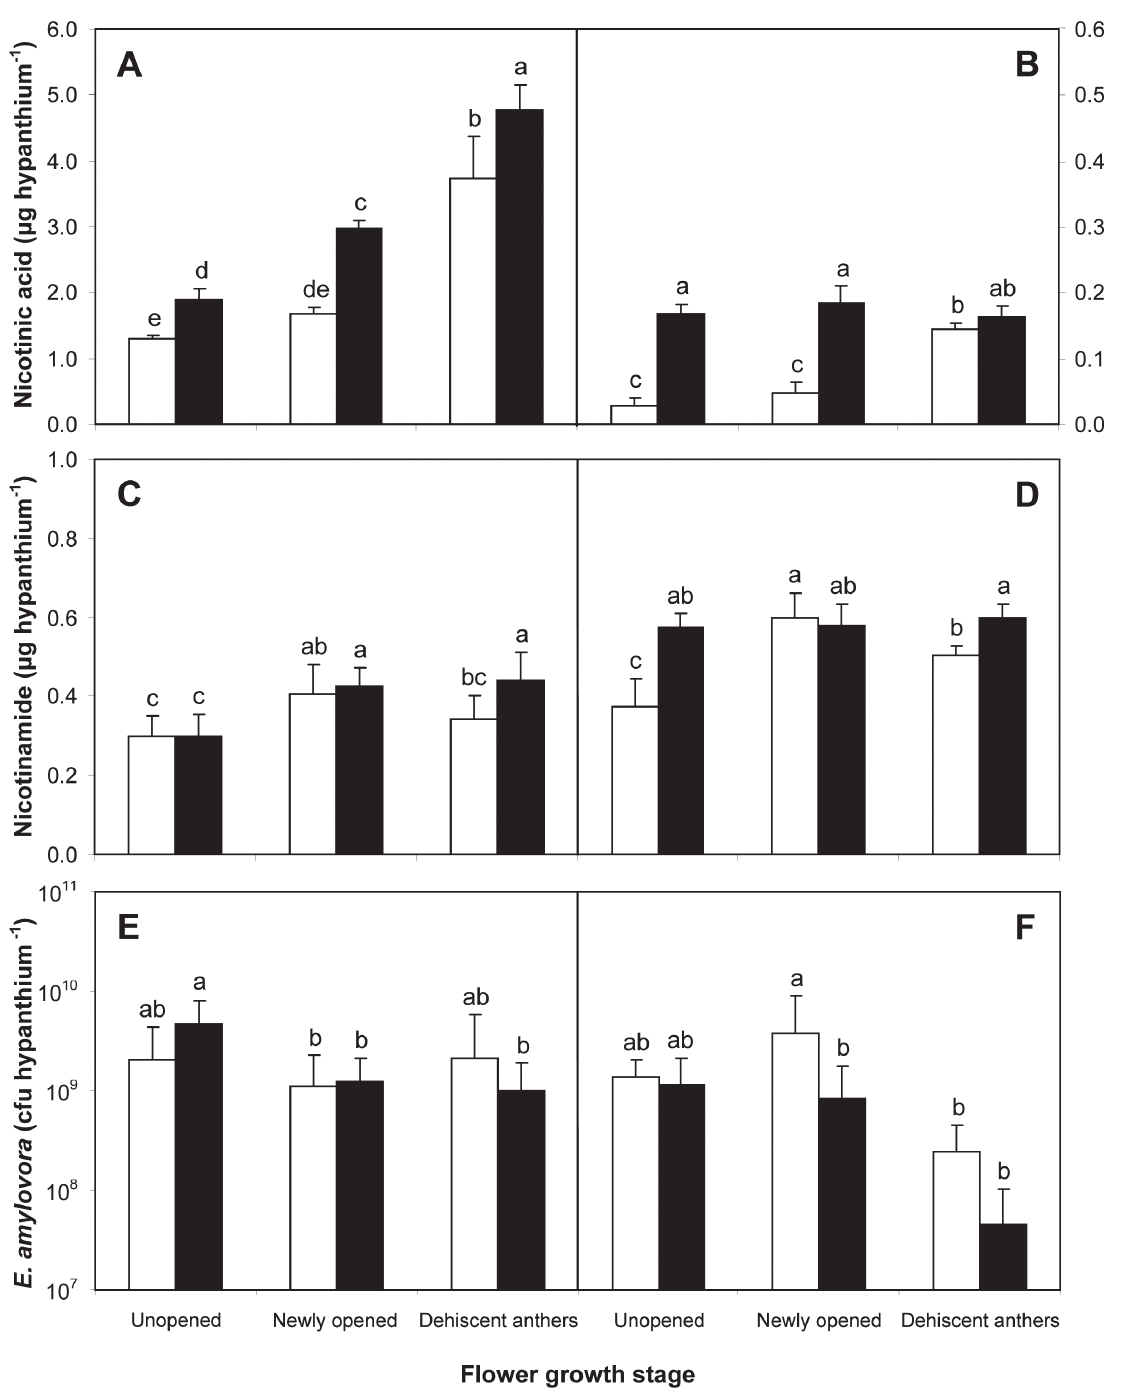
Figure 3. Influence of the flower growth stage in pear cv. Louise Bonne (A, C, E) and apple cv. Canada Reinette (B, D, F) on the amount of nicotinic acid (A, B), and of nicotinamide (C, D) on the hypanthium and on the Erwinia amylo- vora population (E, F). Flowers were collected from trees growing at low (white bars) and high altitudes (black bars). Flowers of at least three trees were used for each growth stage and each altitude. For additional information see the caption of Figure